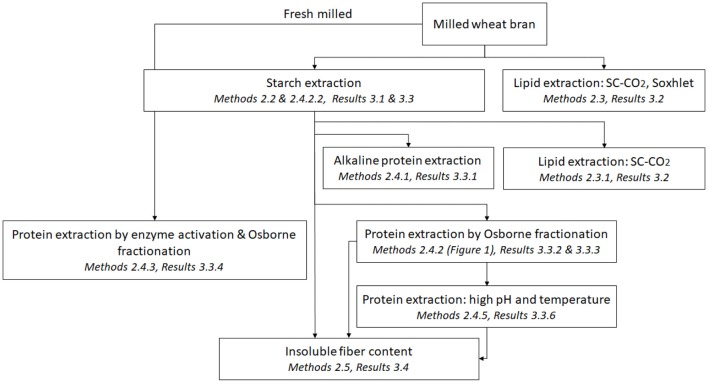
Flowchart overviewing the different sequential processes used in this study.